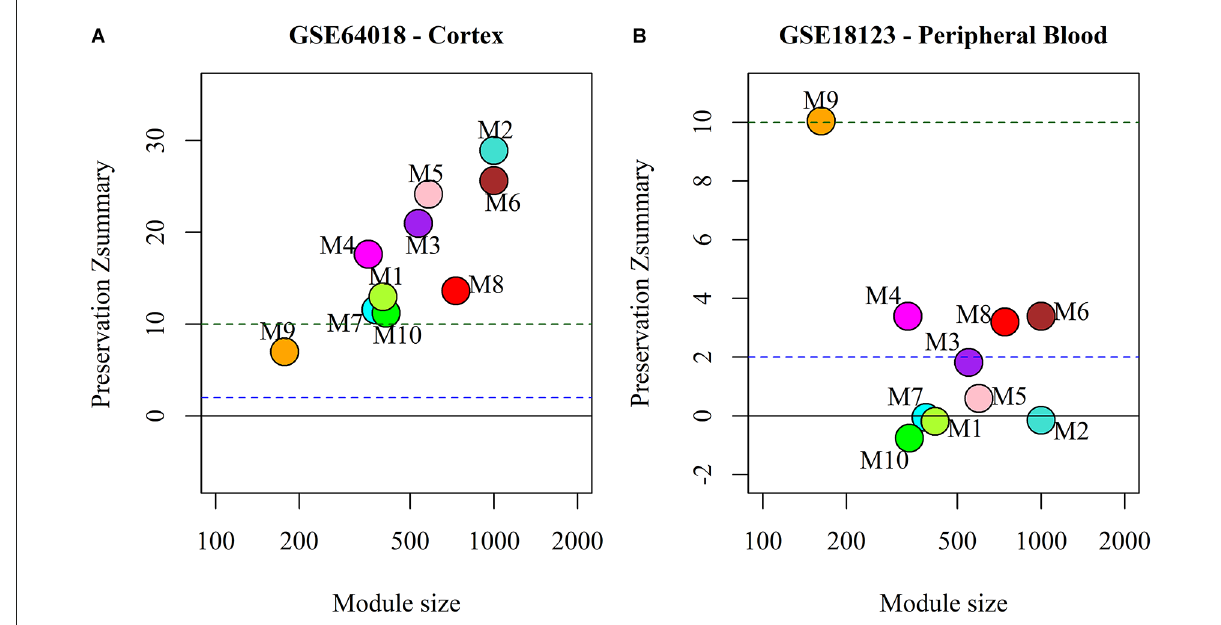
FIGURE4 The preservation of miRNA sponge modules in (A) ASD cortex and (B) PBMC